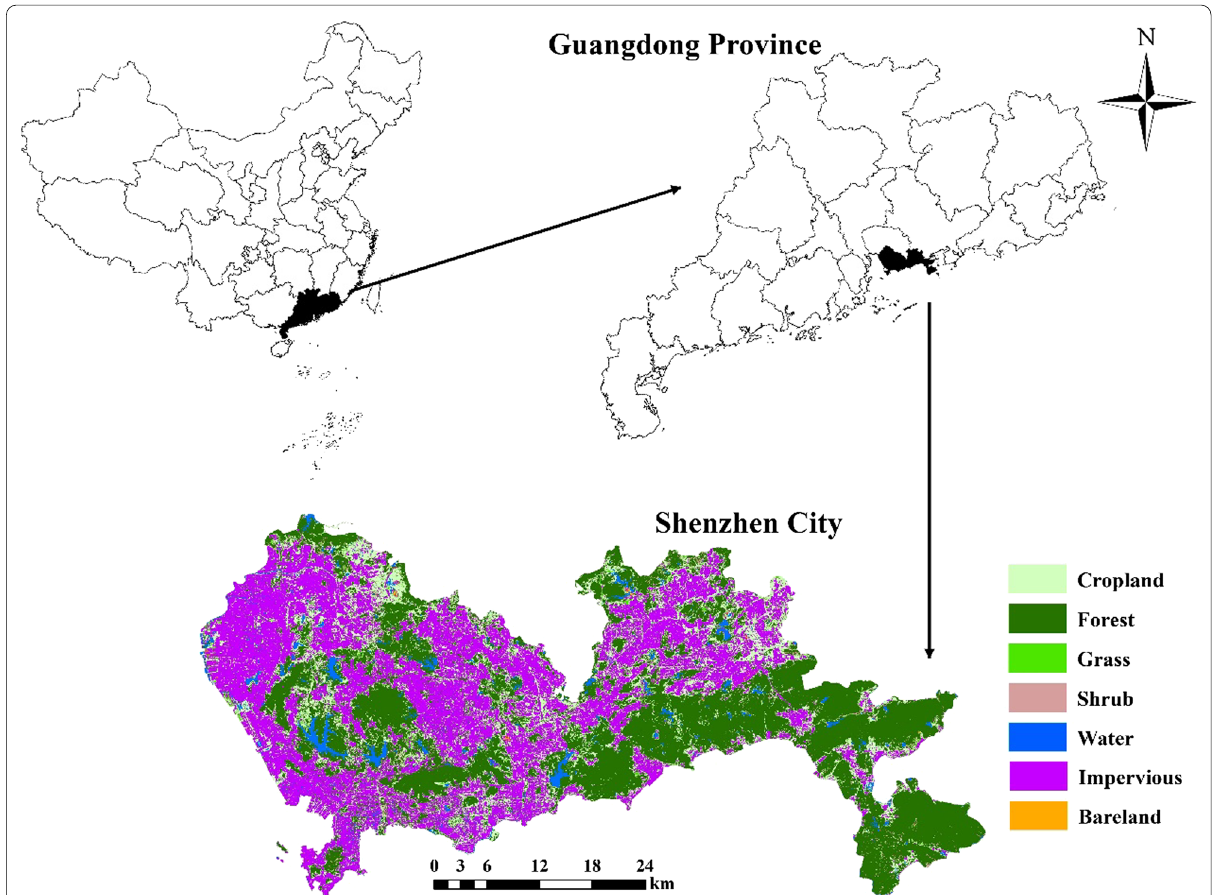
Fig. 1 Location and land‑cover of the study area. The top‑left subgraph shows an administrative map of China and the geographical location of Guangdong province. The top‑right shows an administrative map of Guangdong province and the geographical location of Shenzhen City. And the bottom map shows land‑cover in Shenzhen